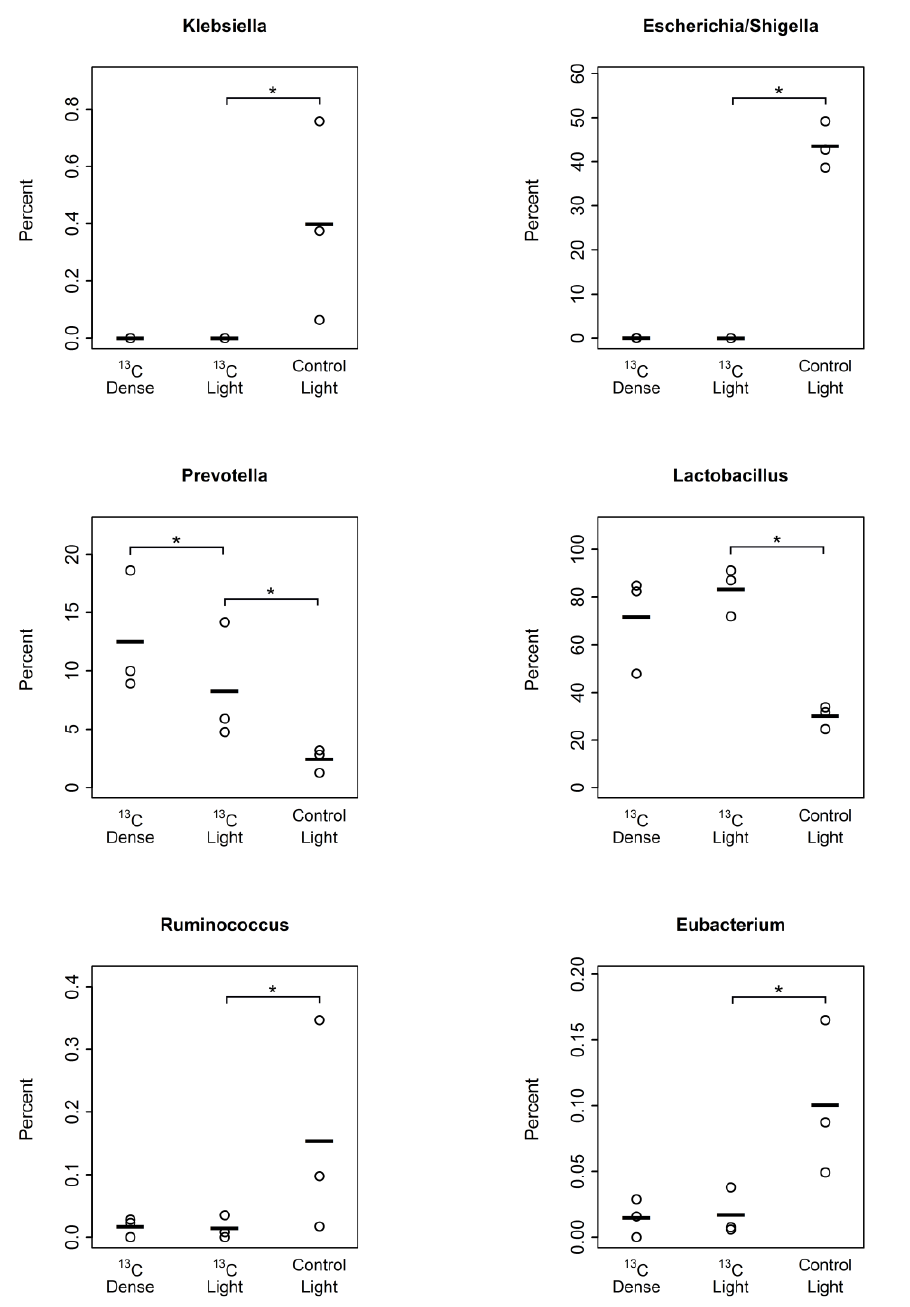
Figure 5. Plots of genus-level bacterial taxa significantly altered ( p < 0.05) between fractions 12–14 in control cultures without sialic acid (Control Light, n = 3), fractions 12–14 in cultures with 13 C-sialic acid ( 13 C Light, n = 3), and fractions 4–6 in cultures with 13 C-sialic acid ( 13 C Dense, n = 3). Points indicate the percentage of total community and lines indicate the mean. * Indicates significant difference ( p < 0.05) in relative proportions determined by Wilcoxon rank sum